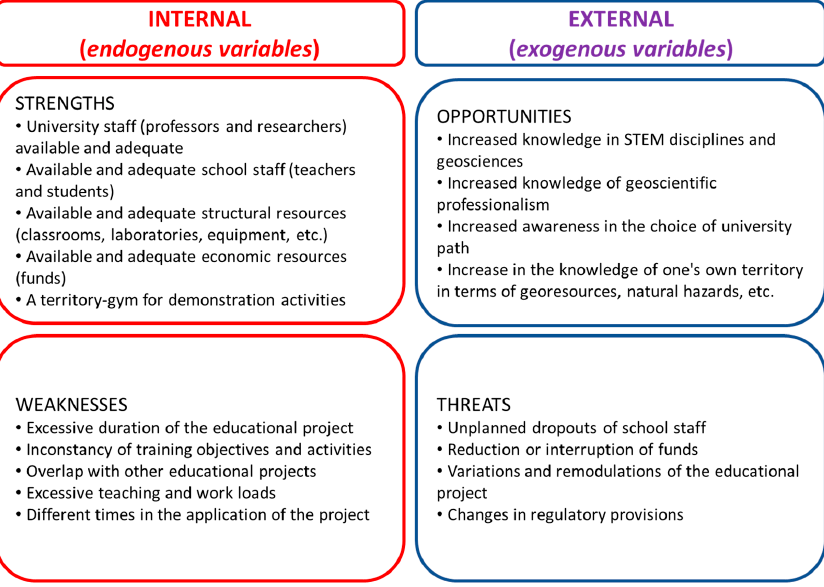
Figure 15. The SWOT analysis of PLS–PNG/GEOLAB–UNISANNIO.